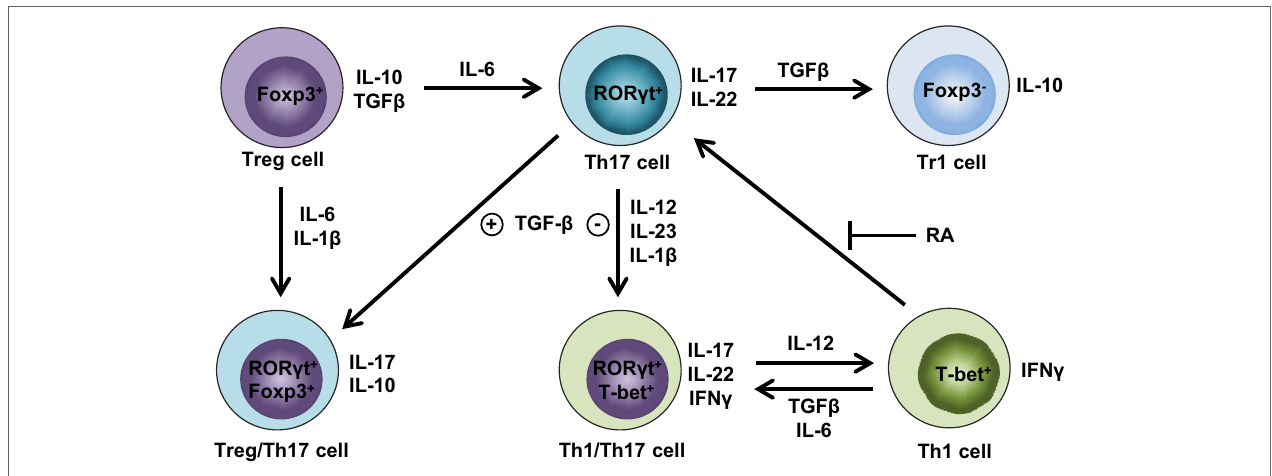
FiGURe 1 | Cytokine milieu orchestrates Treg and Th17 cell plasticity . Th17 cells lose stability in the absence of TGF β and presence of IL-12, IL-23, and IL-1 β , favoring IFN γ expression and differentiation into Th1/Th17 cells that produce both Th1 (e.g., IFN γ ) and Th17 (e.g., IL-17, IL-22) cytokines. Further augmentation of IL-12 can fully convert Th1/Th17 cells into Th1 cells, whereas this process can be reverted by either TGF β and IL-6 or in the absence of retinoic acid (RA) in favor of Th1/Th17 or Th17 cells, respectively. Alternatively, the abundance of TGF β in the absence of IL-6 drives Th17 cells toward regulatory phenotypes, such as either ROR γ t + Foxp3 + Treg/Th17 cells or Foxp3 − Tr1 cells. If proinflammatory cytokines are present, including either IL-6 or IL-1 β and IL-6, Foxp3 + Tregs have the ability to transdifferentiate into either Th17 or Treg/Th17 cells,